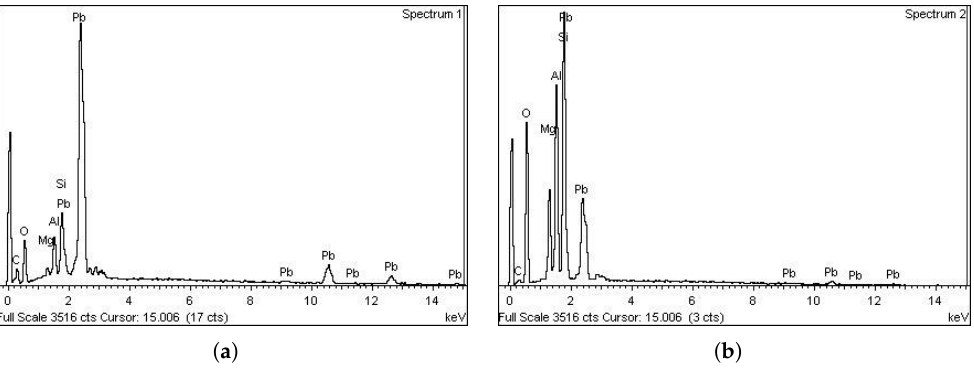
Figure 5. EDX spectroscopy analysis: ( a ) EDX spectrum for the matrix; ( b ) EDX spectrum for the secondary